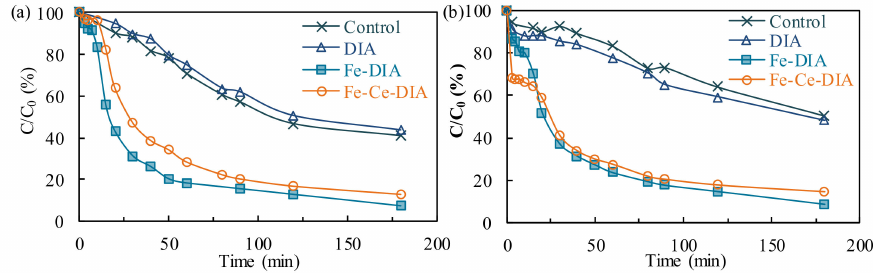
Figure 6. The photocatalytic e ff ect under di ff erent light condition: Visible light ( a ); ultraviolet light ( b ).